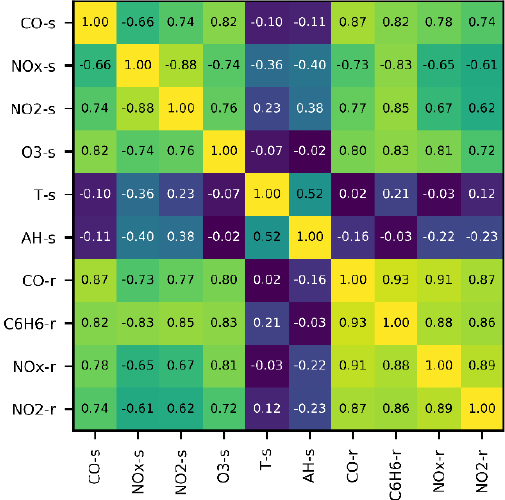
Figure 3. Spearman rank correlation matrix of sensor (s) and reference (r) signals.